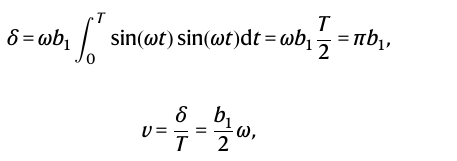
Fig. 4 | Mechanismofrolling motionalong the acoustic virtual wall. a Rotation of a microchain in the absence of an acoustic fi eld. The 1/4-cycle superimposed sub fi gure shows off-center rotation of the microchain, while the 2-cycle sub fi gure shows its fi nal rotational pro fi le to be like a circle. No noticeable motion is observed. b Rotationofamicrochaininthepresenceofaone-dimensionalacoustic standing wave fi eld. The microchain exhibits off-center rotation and rolling along the acoustic pressure nodal line. The white dotted lines of ( a ) and ( b ) respectively denote the rotational centerline and the acoustic pressure nodal line. The green curved arrow denotes the rotational direction. The yellow arrow and dotted line denote the rolling direction and the net displacement, respectively. Scale bar, 50 μ m. c Superimposed time-lapse images of a microchain undergoing one rota- tional cycle. The acoustic excitation voltage and frequency were 20 V PP and 1.55MHz, respectively. The magnetic rotational direction was counterclockwise,